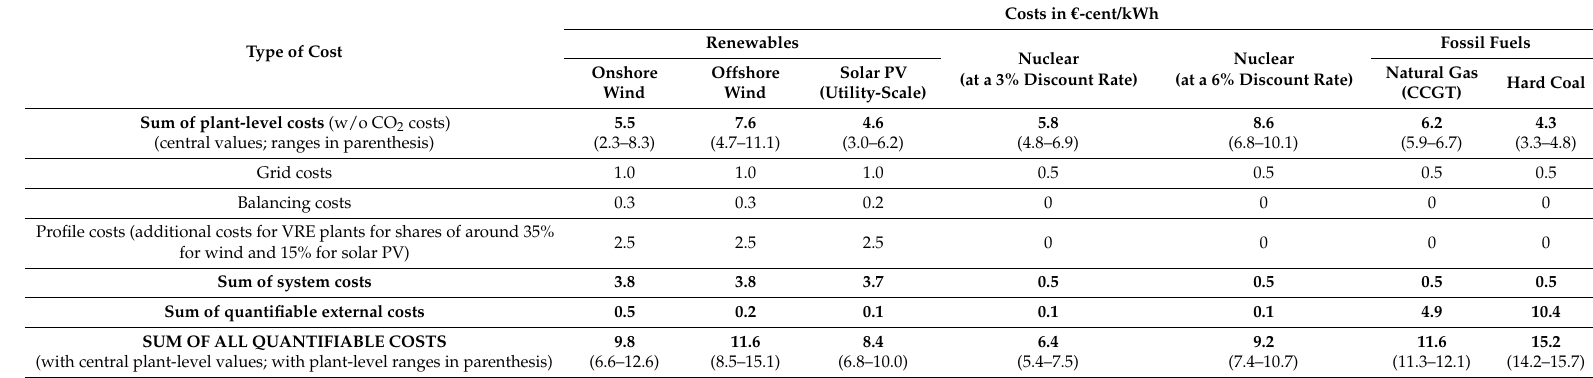
Costs in € -cent/kWh Renewables Fossil Fuels Nuclear Nuclear Onshore Offshore Solar PV Natural Gas (at a 3% Discount Rate) (at a 6% Discount Rate) Hard Coal Wind Wind (Utility-Scale) (CCGT) 0.3 0